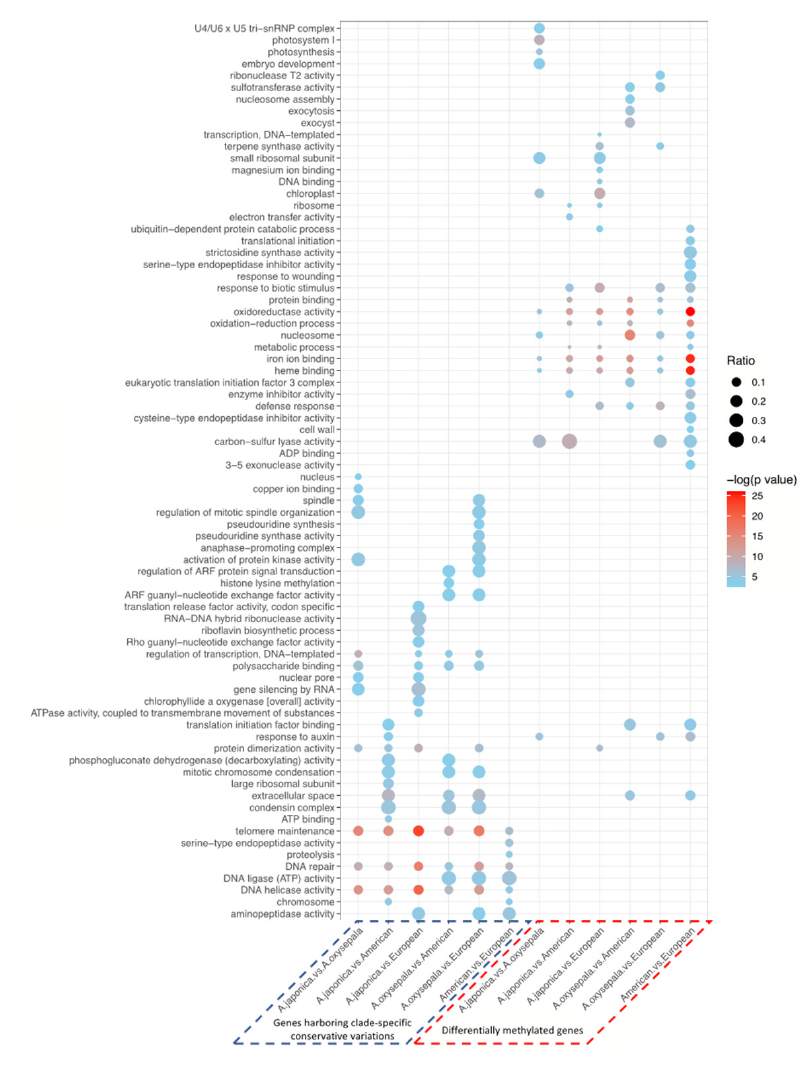
Figure 3. Functional enrichment of the genes harboring highly impactful CCVs and DMGs. CCV- containing genes, specific to either of the two lineages/species being compared, were merged to construct a target gene set. Ratio denotes proportion of CCV-containing genes or DMGs in the corresponding gene set of interest. Absence of dot indicates no significant